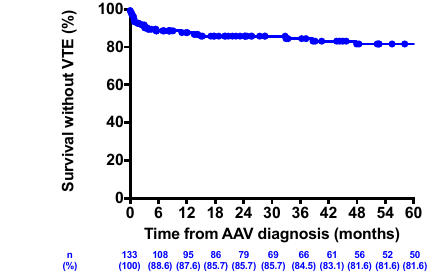
Figure 2. Survival free of thromboembolic events.